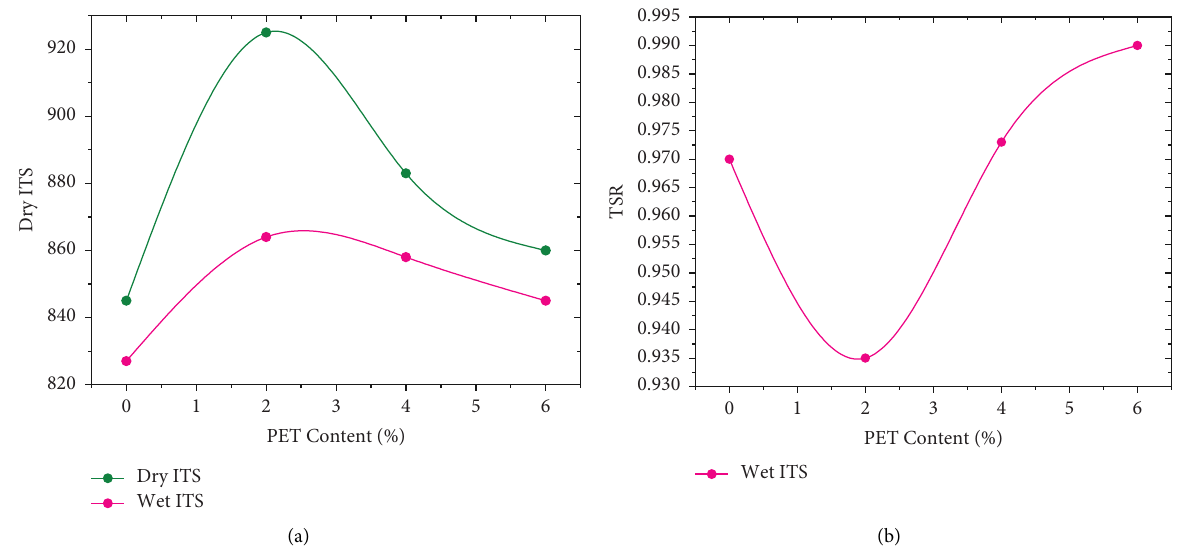
Figure 4: (a) Indirect tensile strength and (b) indirect tensile ratio